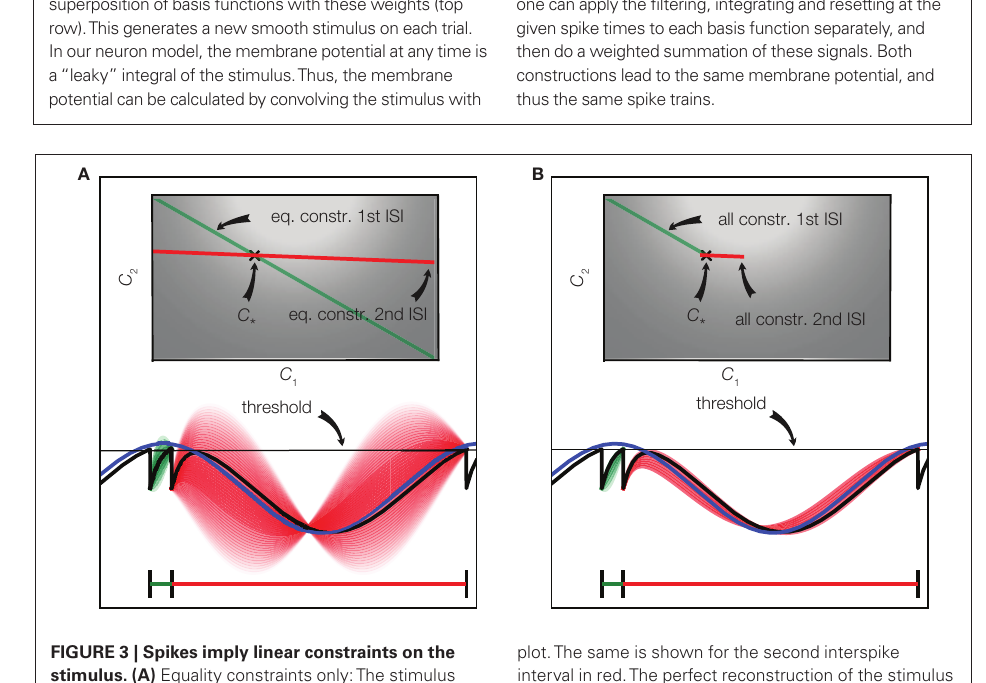
Figure 3 | Spikes imply linear constraints on the stimulus. (A) Equality constraints only: The stimulus (blue) consists of a superposition of two basis function (one sine and one cosine function). The resulting membrane potential is plotted in black. Whenever the potential reaches the threshold (gray) a spike is fired. The linear constraint originating from the equality constraints of the first interspike interval are plotted in green in the upper plot. A discrete set of points along this linear constraint are selected and the corresponding membrane potentials are plotted in green in the lower